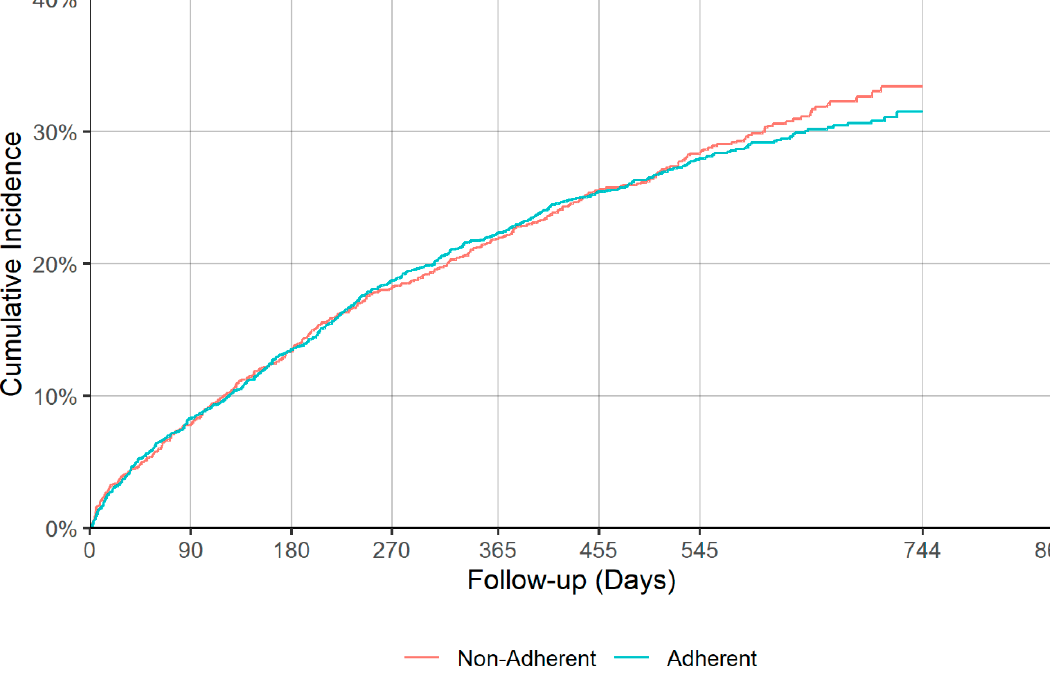
Figure 8. IPT-weighted cumulative incidence function of falls/fractures, adjusting for death before hospitalization as a competing risk (continuation phase). Modified Gray’s test p = 0.747.